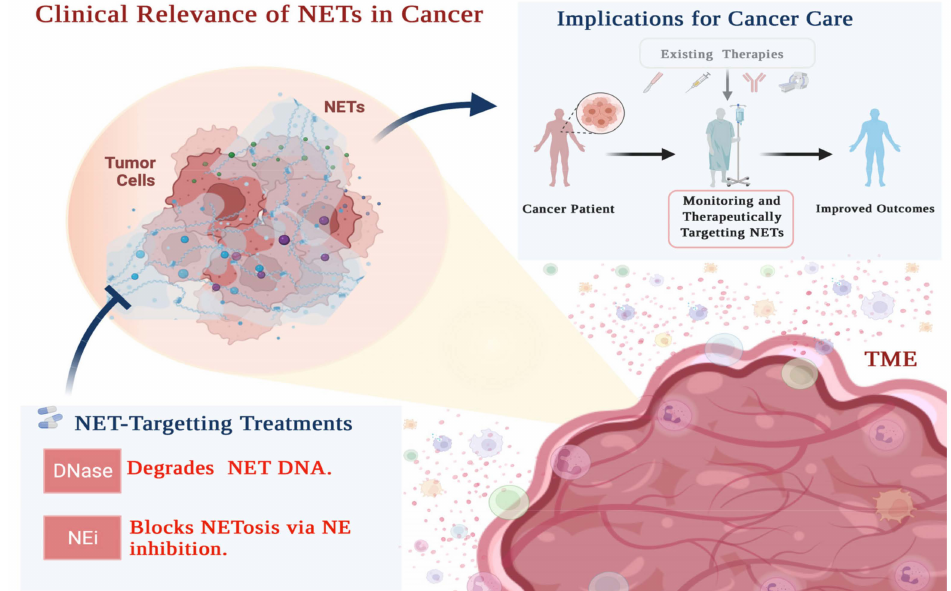
Figure 2. NETs are relevant for the clinical management of cancer. The emerging role of NETs in cancer progression and treatment resistance highlights their relevance to the management of aggressive cancers. Their status as a potential therapeutic target is underscored by their well- described functional role in various mechanisms of treatment resistance [61,76,77,81,128]. Targeting NETs pharmacologically offers a novel avenue to mitigate poor treatment efficacy and ultimately improve outcomes across neoplasms. Potential modalities thereof include the use of DNase and/or NEi. In additional to a therapeutic target, NETs may allow for enhanced prognostication and monitoring of response as a clinical biomarker [3]. The potential implications of NETs for cancer care could be realized through a combination of NET-targeting therapy along with regular